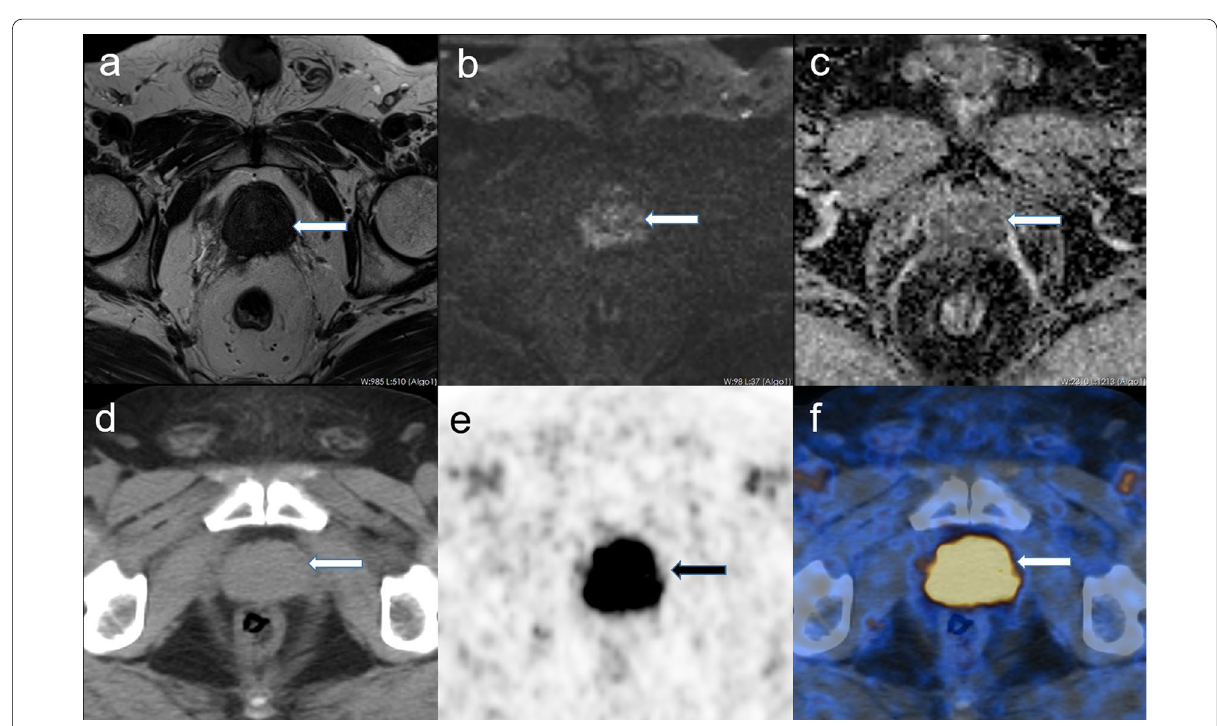
Fig. 2 High-risk PCa with mpMRI ( ) and 68 Ga-PSMA PET/CT ( ). A 69-year-old patient whose serum PSA level was 15.4 ng/ml and whose GS was − + 5 5. There is no significant lesion in the prostate gland in the pelvic MRI scan ( a T2w; b b 1500 DWI), while in the 68 Ga-PSMA PET/CT there is a + strong tracer uptake highly likely to be diagnosed (arrow in e and f ). a – c MRI; d – f 68 Ga-PSMA PET/CT; a T2w; b b 1500 DWI; c ADC map; d low-dose CT; e maximum intensity projection of the PET; f fusion of 68 Ga-PSMA PET and low-dose CT